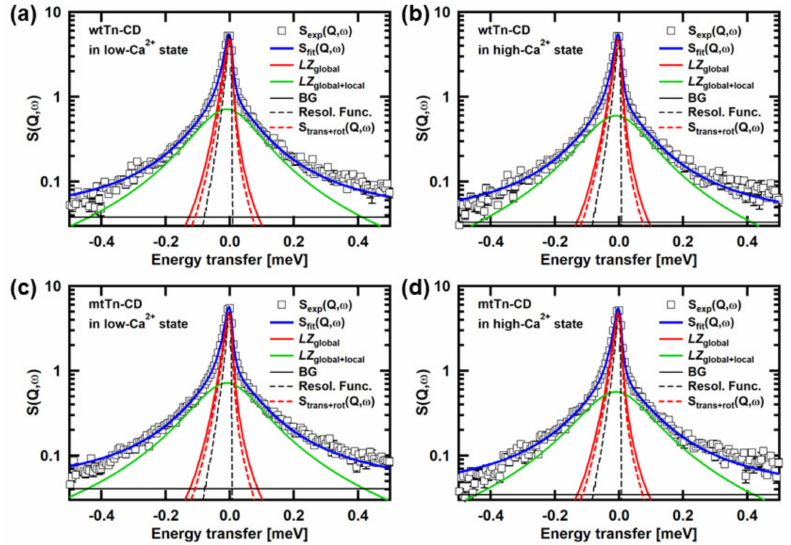
Figure 2. Examples of the QENS spectra. The spectra at Q = 1.05 Å − 1 of ( a ) the wtTn-CD in the low-Ca 2+ state, ( b ) the wtTn-CD in the high-Ca 2+ state, ( c ) the mtTn-CD in the low-Ca 2+ state, ( d ) the mtTn-CD in the high-Ca 2+ state, are shown. The fits to the experimental spectra using Equation (1), the simulated spectra of S trans+rot ( Q , ω ), and the resolution function are also shown. The experimental spectra shown were obtained from the measurements carried out during the study described in